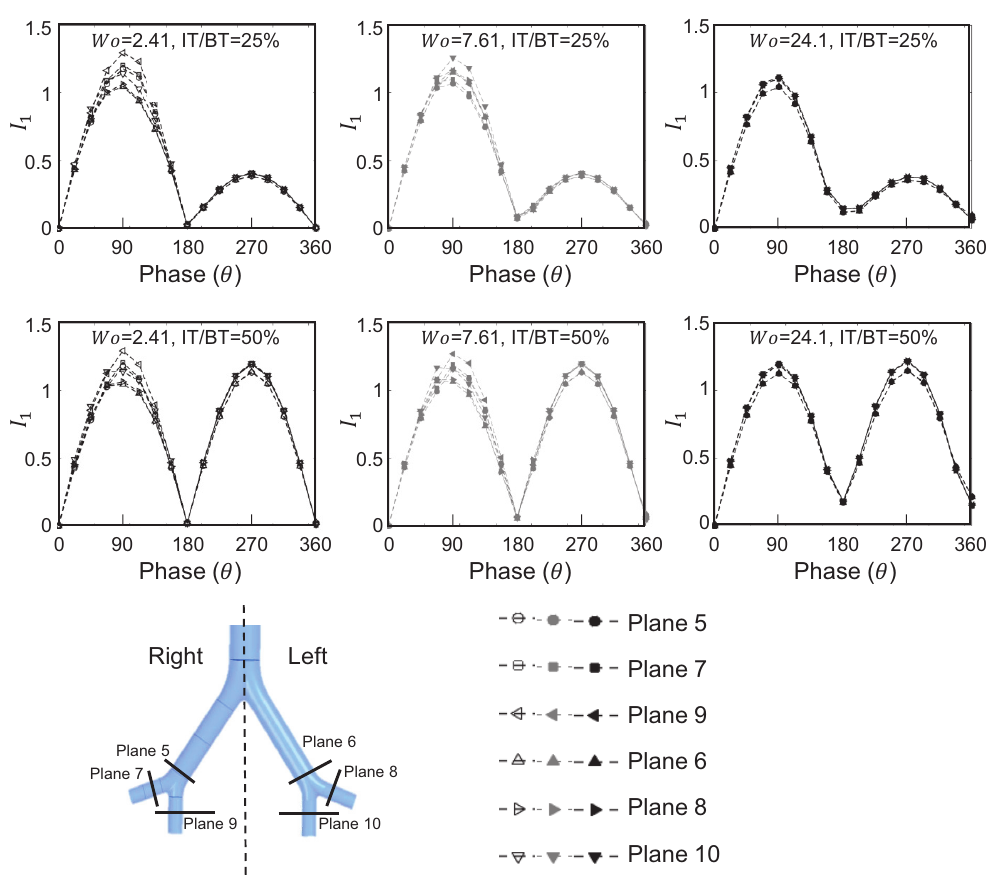
Figure 13. Integral parameter I 1 calculated at Planes 5–10 for all breathing conditions at IT/BT = 25% ( top row ) and IT/BT = 50% ( bottom row ). Planes 5 (- - - -), 7 (- - (cid:4) - -), and 9 (- - (cid:74) - -) are from the right bifurcation. Planes 6 (- - (cid:78) - -), 8 (- (cid:32) - (cid:73) - -) and 10 (- - (cid:72) - -) are from the left bifurcation. Open, gray-filled, and black-filled markers represent Wo conditions of 2.41, 7.61, and 24.1,